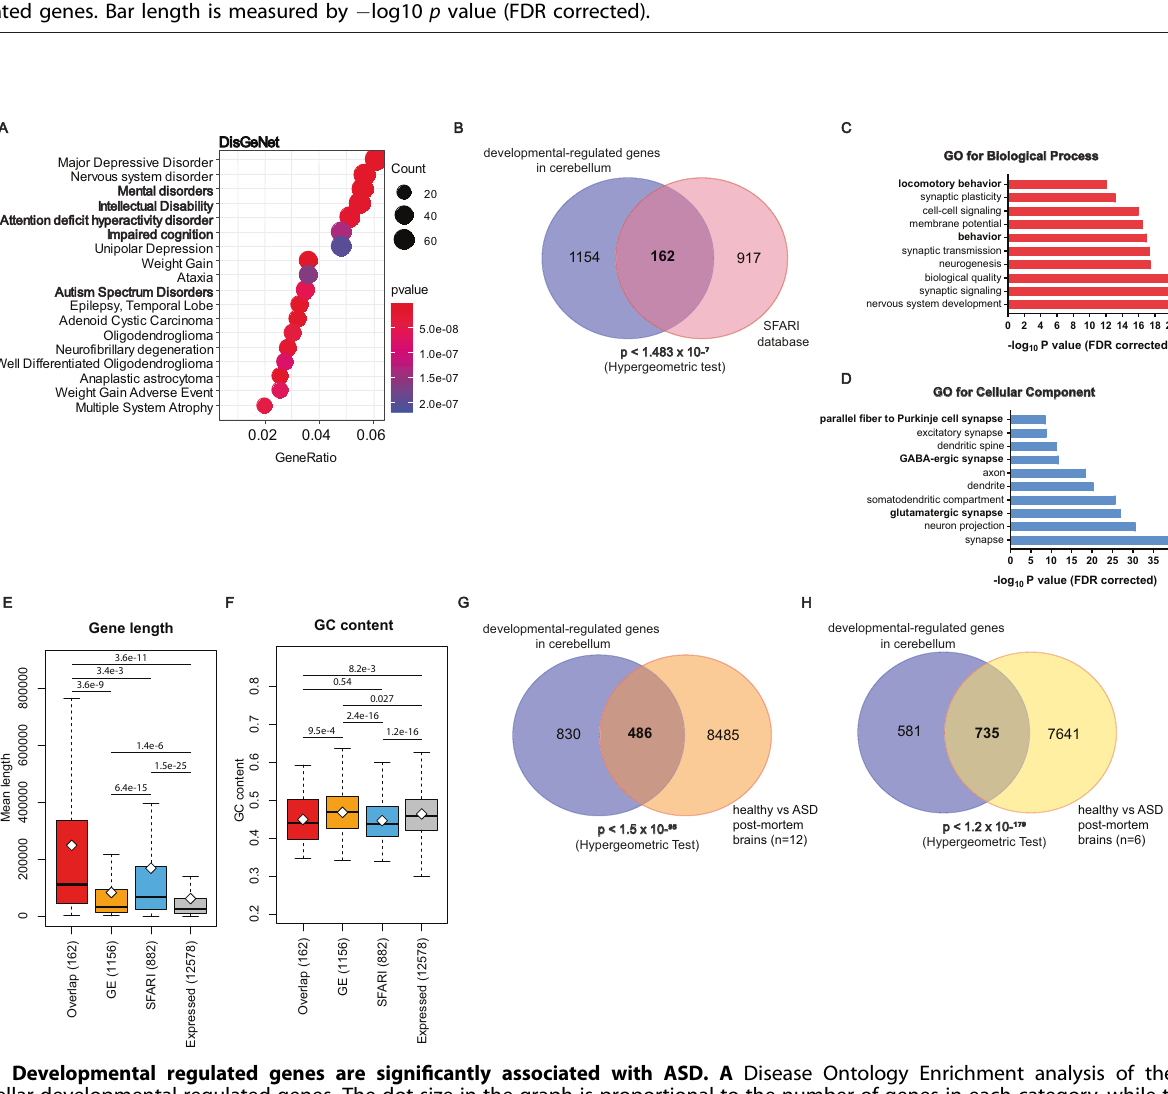
Fig. 1 A dynamic gene expression programme characterizes post-natal cerebellum development in mice. A Temporal clustering based on the relative gene expression at P1, P10, and P30 of the 1316 developmental-regulated genes in the mouse cerebellum. Polygon plots show the median values as a black line. The dark blue represents the 0.25 – 0.75 quantiles and the light blue 0.1 – 0.9 percentiles. The expression values were normalized by maximum expression value. B Analysis by qPCR of one representative developmental regulated gene for each cluster. Data are expressed as: mean ± SEM, n = 6, * p value ≤ 0.05; ** p value ≤ 0.01; *** p value ≤ 0.001; **** p value ≤ 0.0001; number = not signi fi cant, test = one-way ANOVA Tukey ’ s multiple comparisons. C GO analysis for Biological Process for each cluster of cerebellum development regulated genes. Bar length is measured by − log10 p value (FDR corrected).